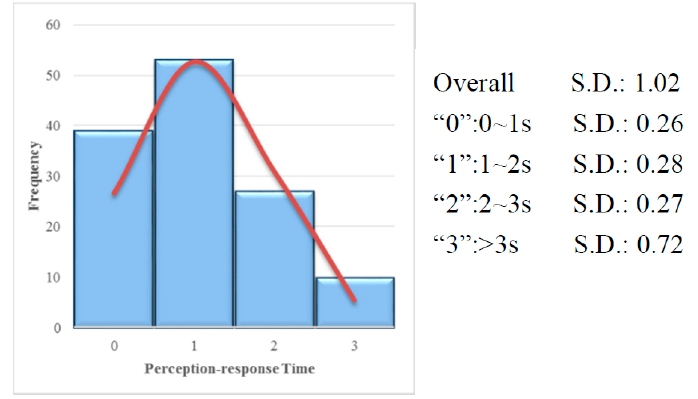
Figure 3. Distribution of perception-response time (all tests).